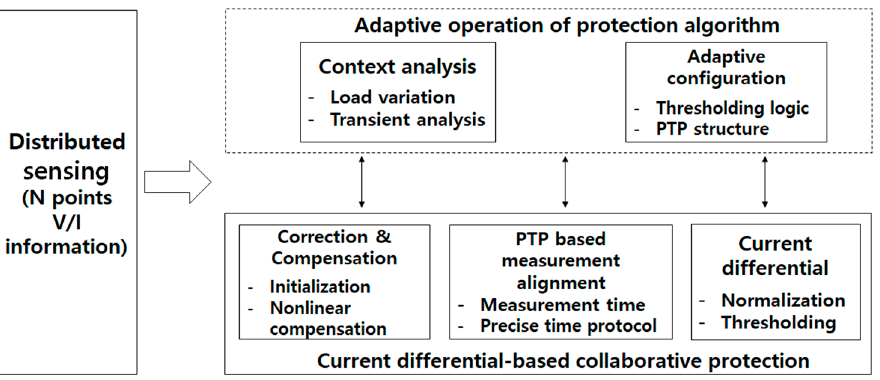
Figure 2. Functional blocks of current differential-based collaborative protection system based on the application of the IEEE 1588 Precision Time Protocol (PTP).